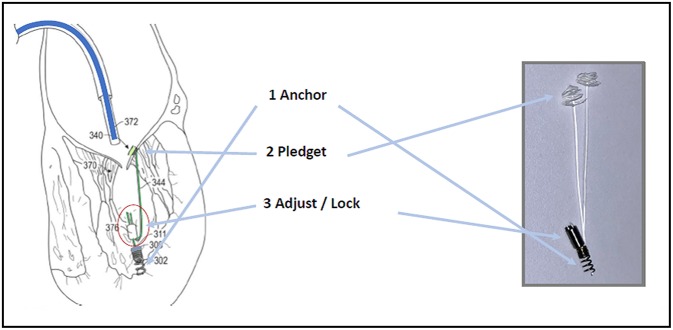
The Pipeline Device.